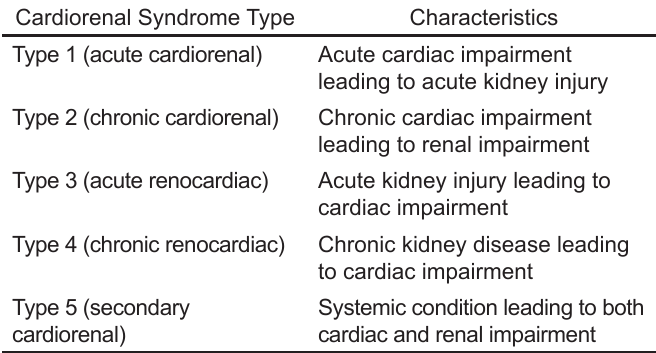
Table 2. Classification of cardiorenal syndrome based on a system proposed by Ronco and McCullough. 2